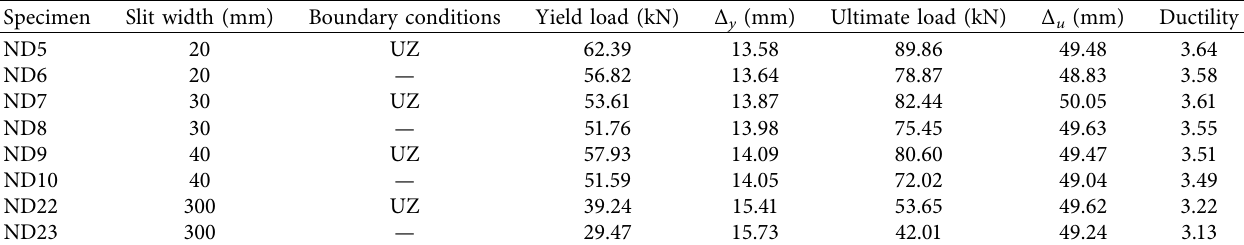
Table 11: Loads, displacement and ductility of different boundary conditions.